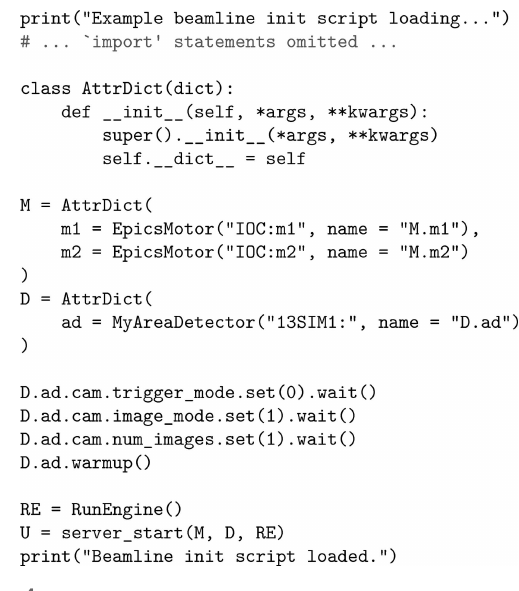
Figure 4 An example IPython startup script for Mamba